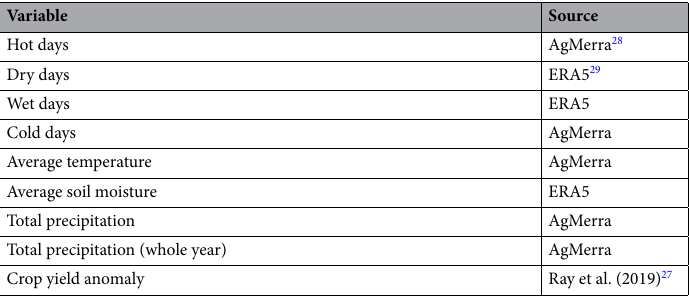
Table 1. The variables of the main analyses (Figs. 1, 2, and 3) and their sources. The variables were calculated for each crop, year, and grid cell. For hot, and dry (cold, and wet) days, we calculated the days above (below) 90th (10th) percentiles for temperature and soil moisture deficit across all years. All indicators were calculated for the growing season except one precipitation indicator, which was calculated for the whole year proceeding harvest. See “Methods” for a more elaborate description about the data processing as well as Table S1 for a comprehensive list of the modelling set-ups conducted in this